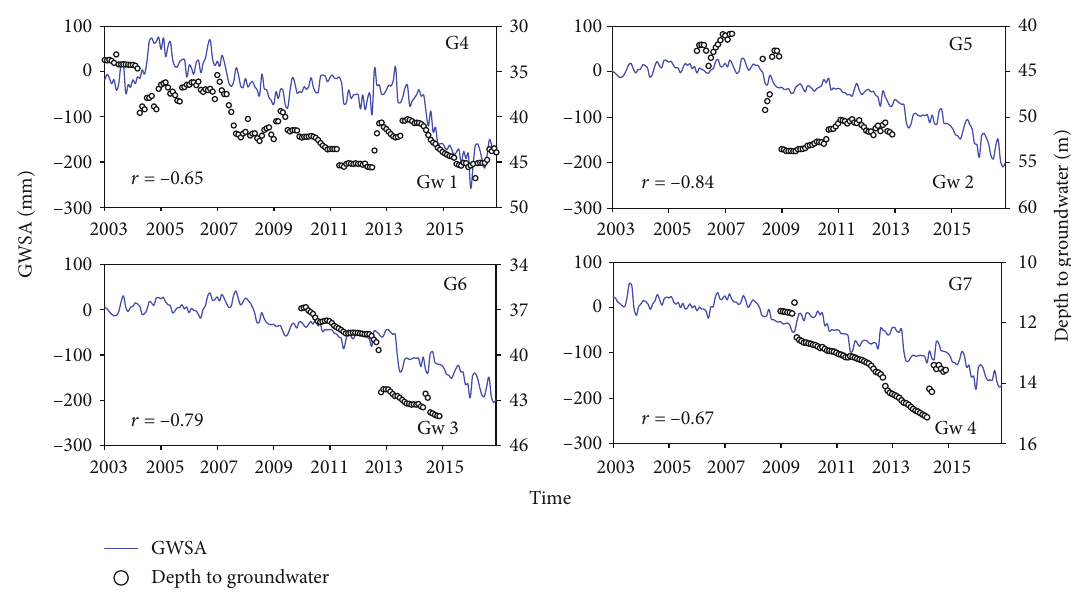
Figure 2: Comparison between the GWSA and the depth to groundwater in four grid